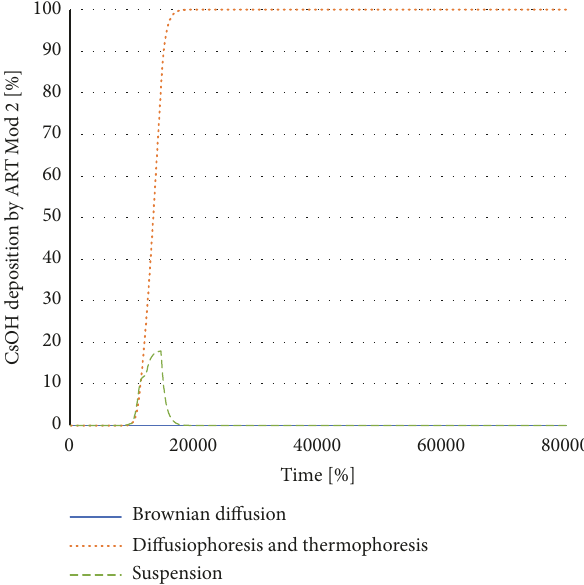
Figure 16: CsOH deposition in wet condenser volume calculated by ART Mod 2.